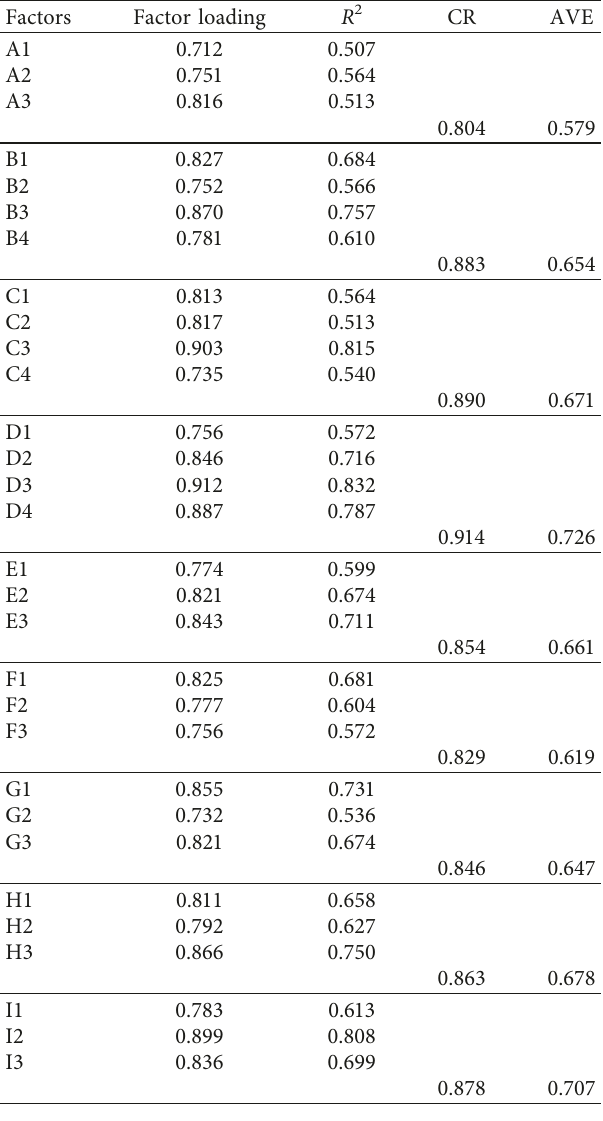
Table 3: Measurement model evaluation.